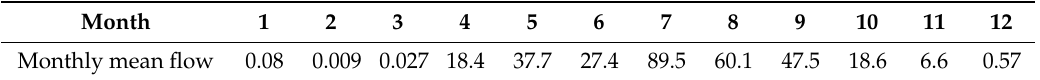
Table A1. Historical monthly flow of Baoqing station in 1956.